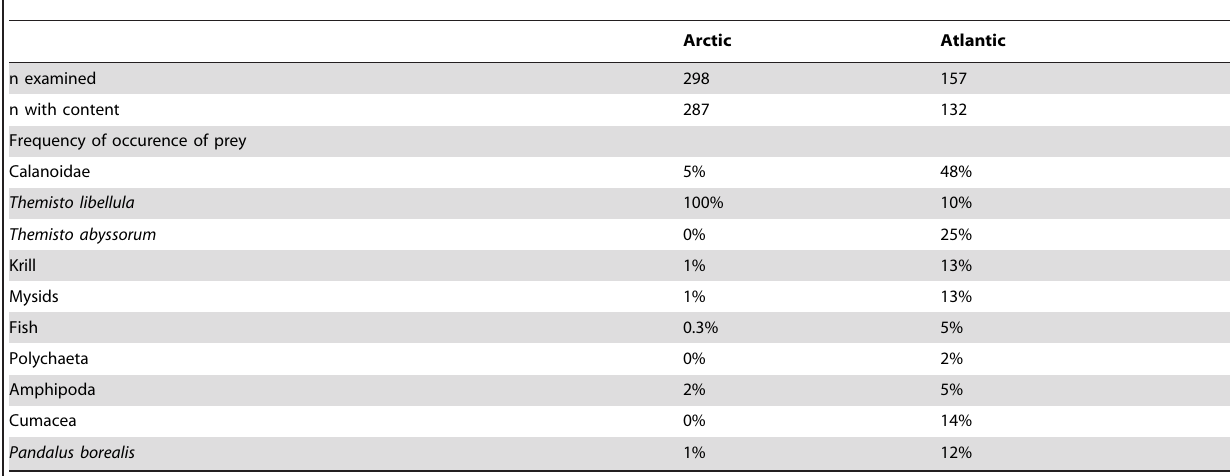
Table 3. Frequency of occurrence (%) of preys in polar cod stomachs.